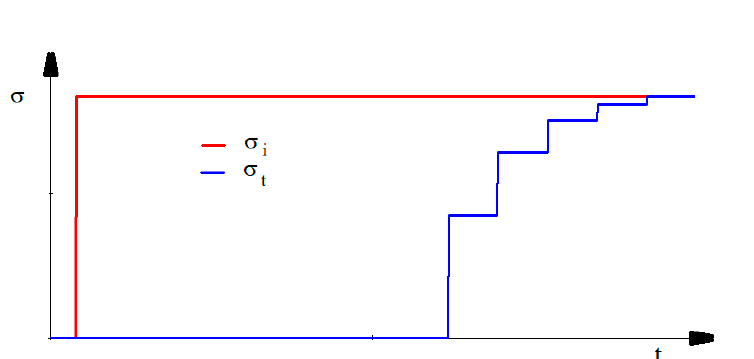
Figure 2. Influence of the measurement error ∆ℎ on the value longitudinal modulus. Regarding the characteristic time necessary for the elastic wave to travel back and forth on the sample, this is calculated with the following formula: 𝜏 (cid:4593) = 2𝑙 (cid:4593) 𝑐 (cid:2868)(cid:4593)